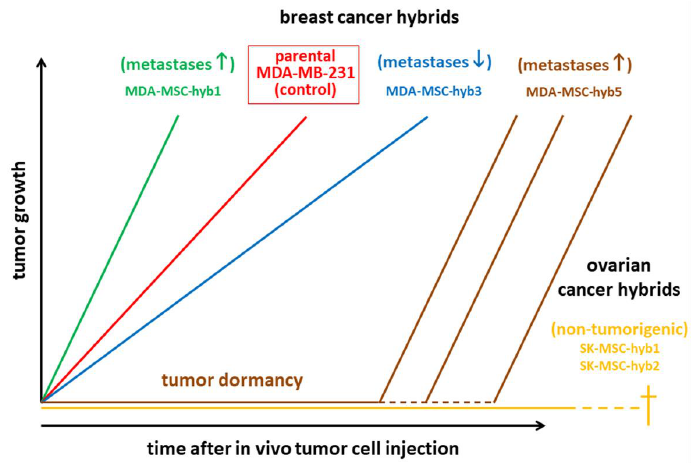
Figure 3. Tumor development of different human breast cancer hybrid cells demonstrates enhanced (green) and reduced (blue) growth properties as compared to the parental breast cancer cells (red) before fusion with mesenchymal stroma/stem-like cells (MSCs) and subsequent PHSP. A third form of tumor growth is characterized by an initial phase of dormancy. The two presented ovarian cancer hybrid populations displayed no detectable tumor development and the animals eventually died of old age.